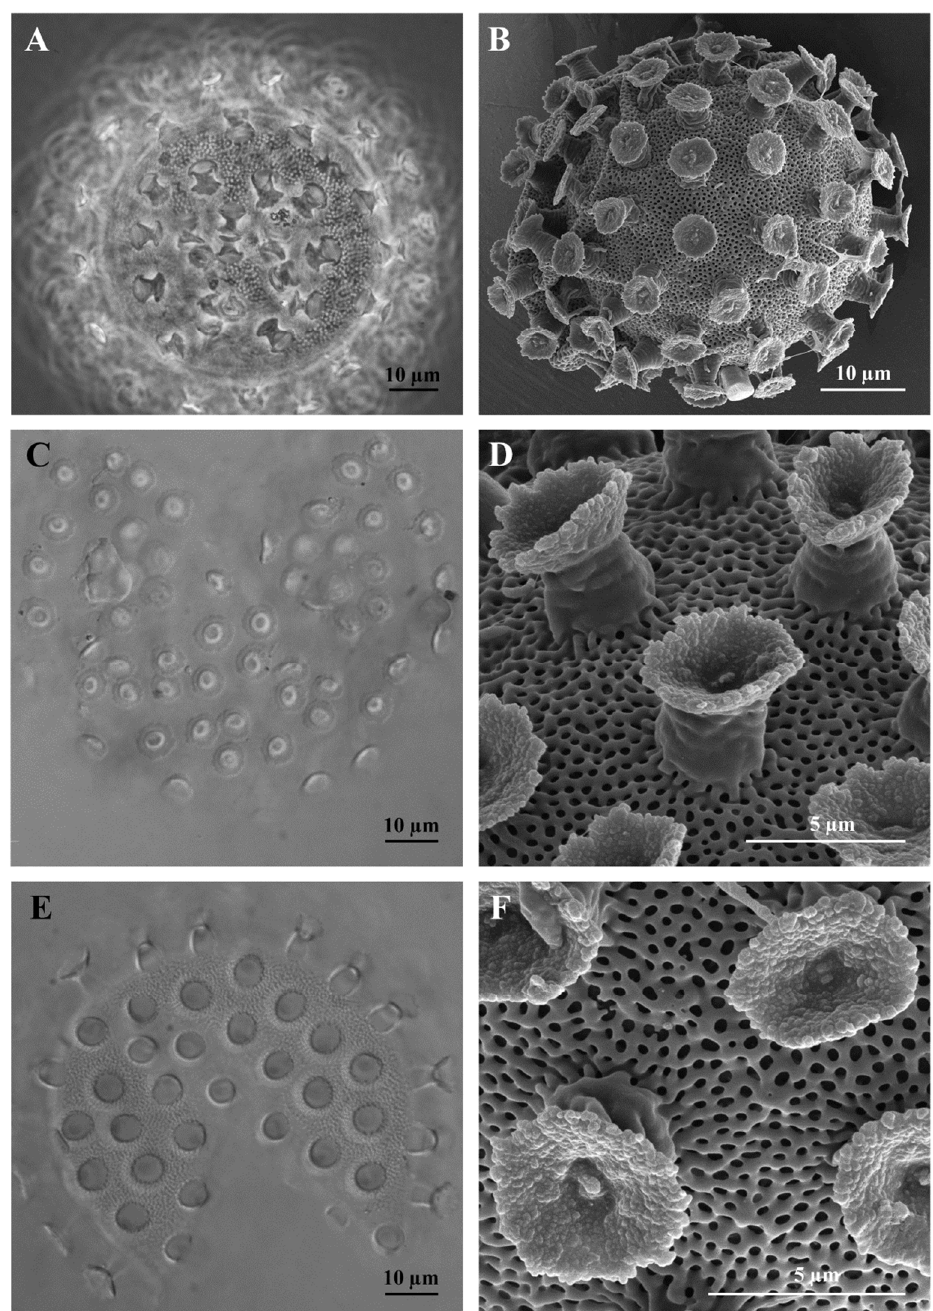
Figure 4. Eggs of Macrobiotus kyoukenus sp. nov. ( A ) In toto egg; ( B ) In toto egg; ( C ) Terminal disks of the egg processes; ( D ) Terminal disks of the egg processes; ( E ) Egg surface between the processes; ( F ) Egg surface between the processes. ( A ) PhC; ( B , D , F ) SEM; ( C , E ) DIC.